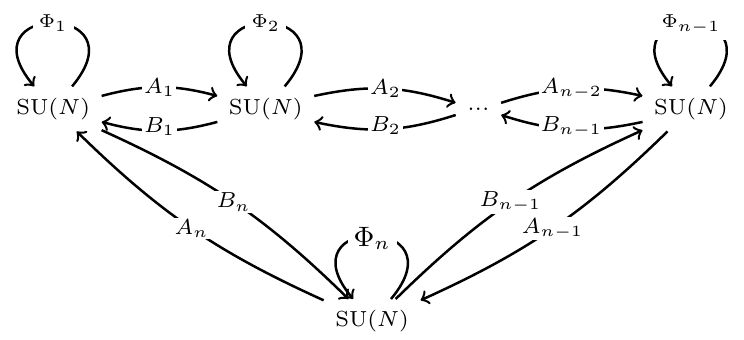
Figure 4. The generalized conifold quiver in